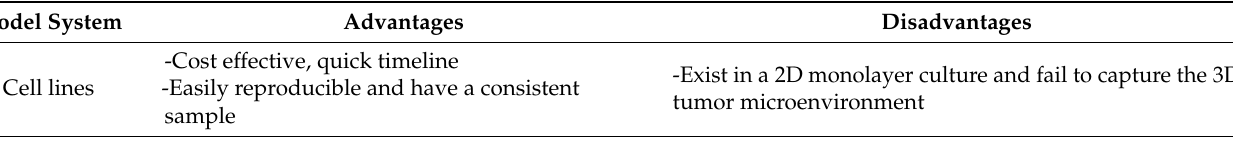
Table 1. Advantages and disadvantages of pre-clinical